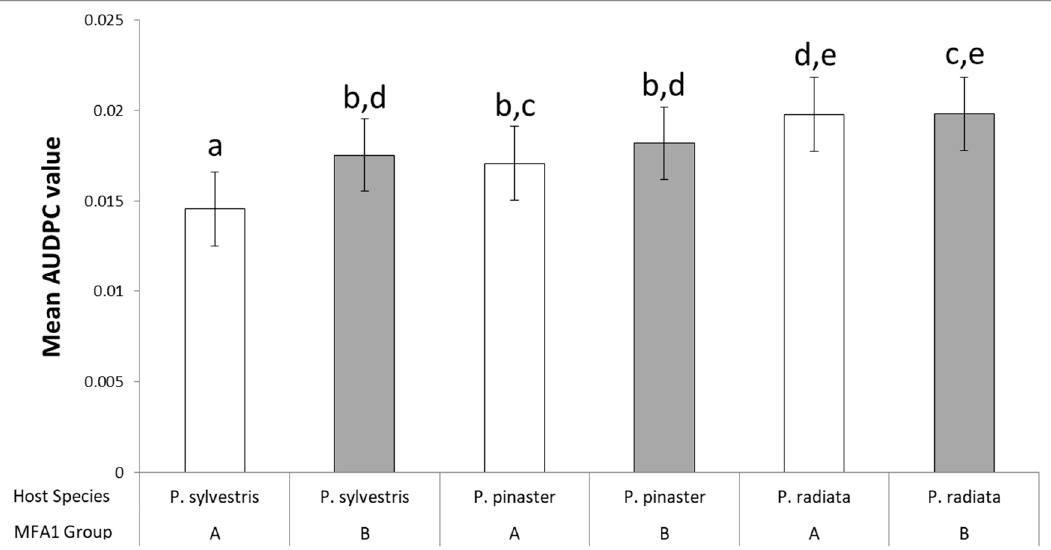
Figure 4. AUDPC values for the three inoculated Pinus hosts separated by multiple factor analysis 1 (MFA1) group. Different letters above bars indicate significant differences in AUDPC values.